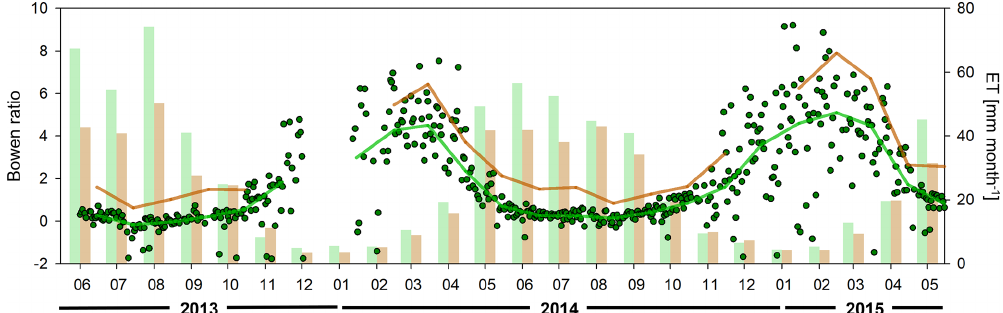
Figure 5. Daily Bowen ratio ( β = (cid:80) Q H / (cid:80) Q E ; dots), monthly Bowen ratio (lines), and gap-filled monthly evapotranspiration (ET; bars) for 2 years (SFP; green, EP; brown).